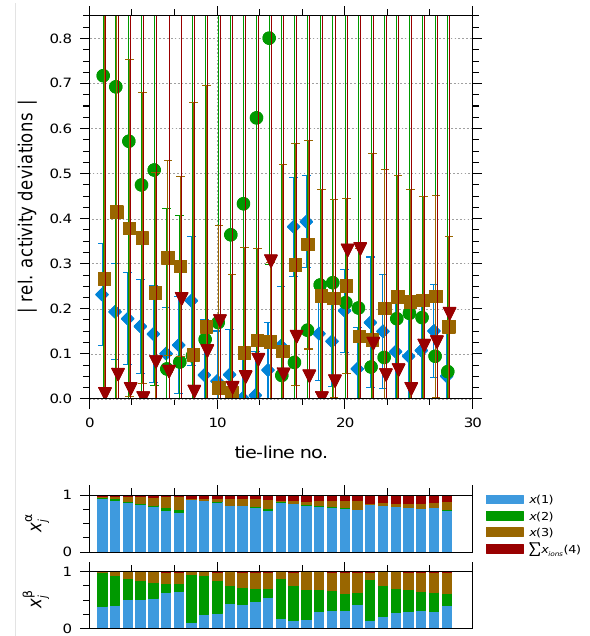
Fig. S0318 (AIOMFAC_output_0313) H 2 O (1) + 4-Methyl-2-pentanone (2) + Acetic_acid (3) + NaCl (4) Temperature: 308 K